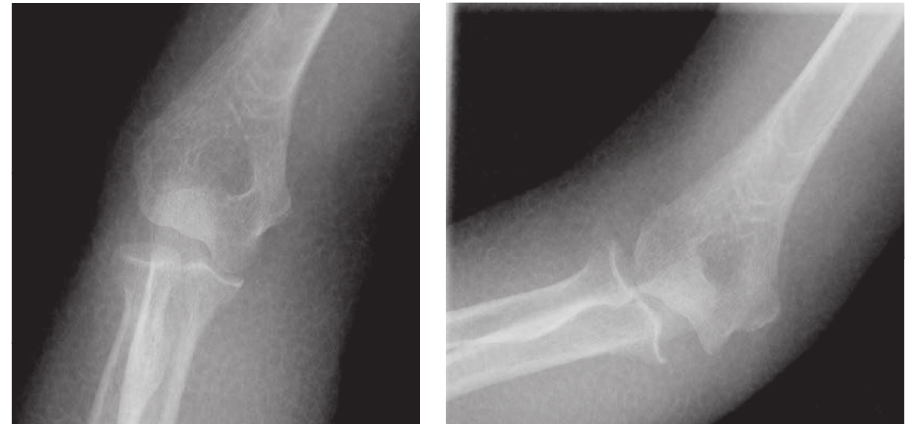
Figure 4: Postreduction radiographs revealed obvious varus and valgus instability of the joint. However, redislocation was not observed in the range of motion from 30 ∘ to 90 ∘ .